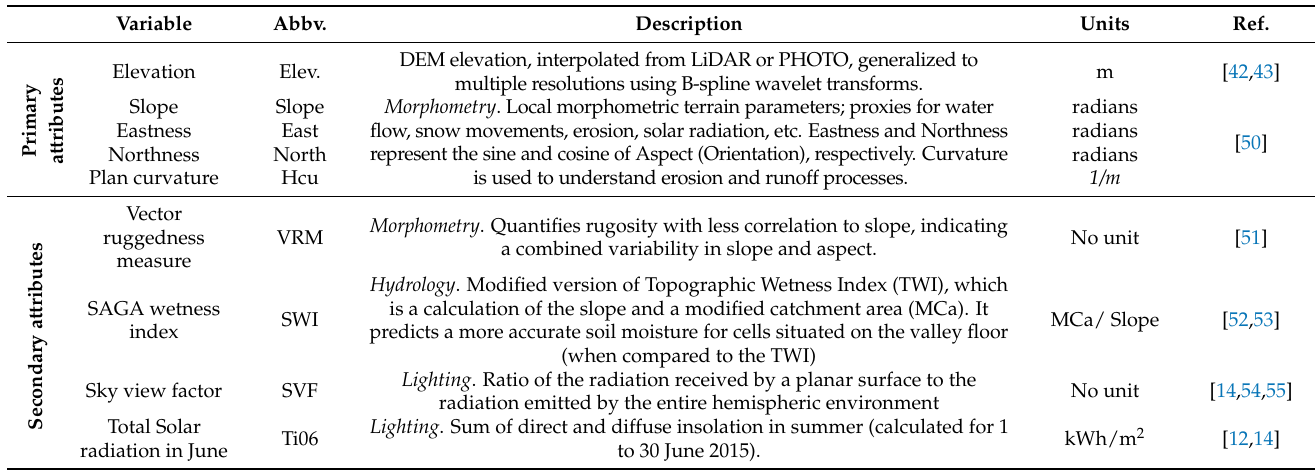
Table 2. Description of independent DEM-derived variables computed at each resolution for LiDAR and PHOTO. See Table S1 in the supplementary material for the parameters used in calculations. Variable